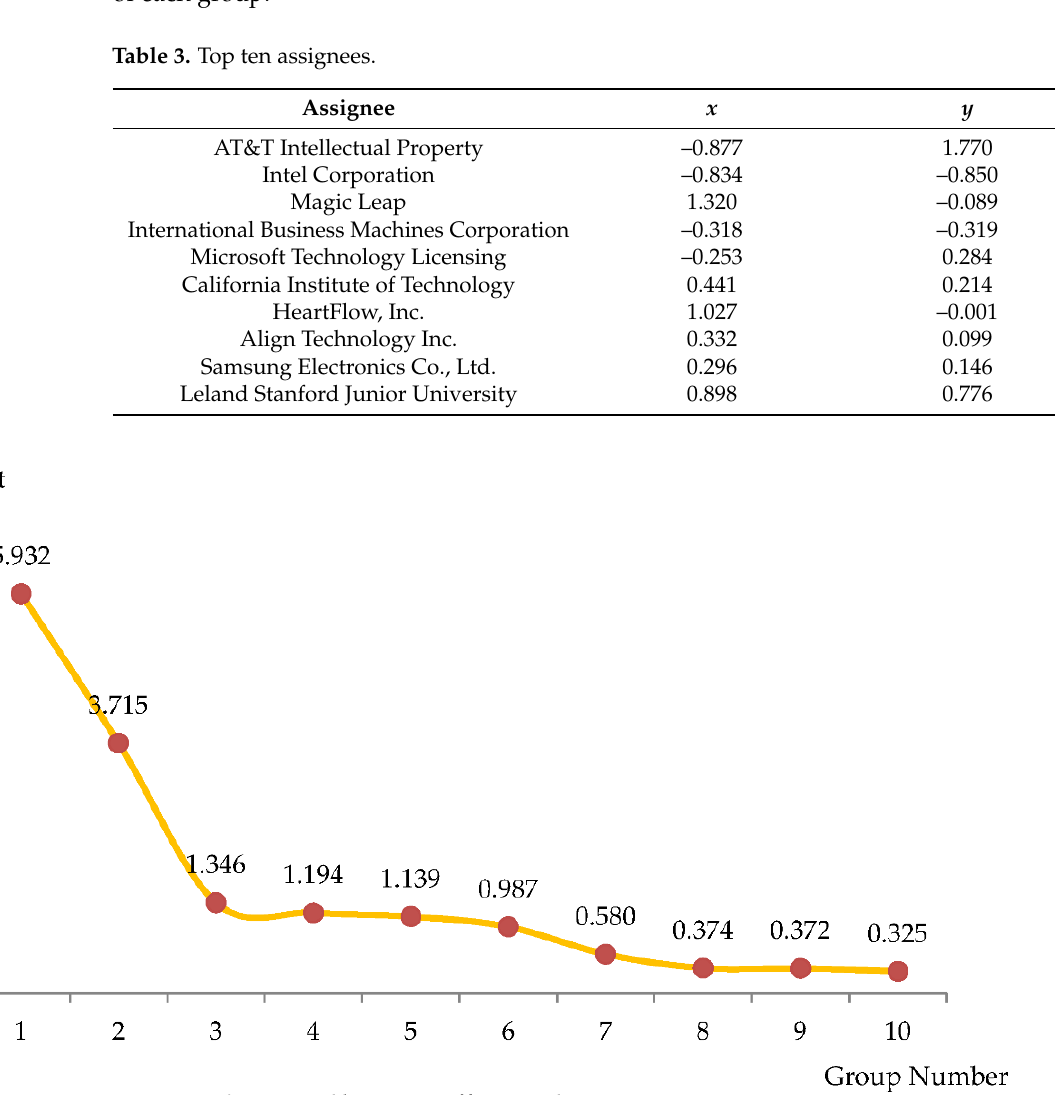
Figure 2. Cluster coefficient change.